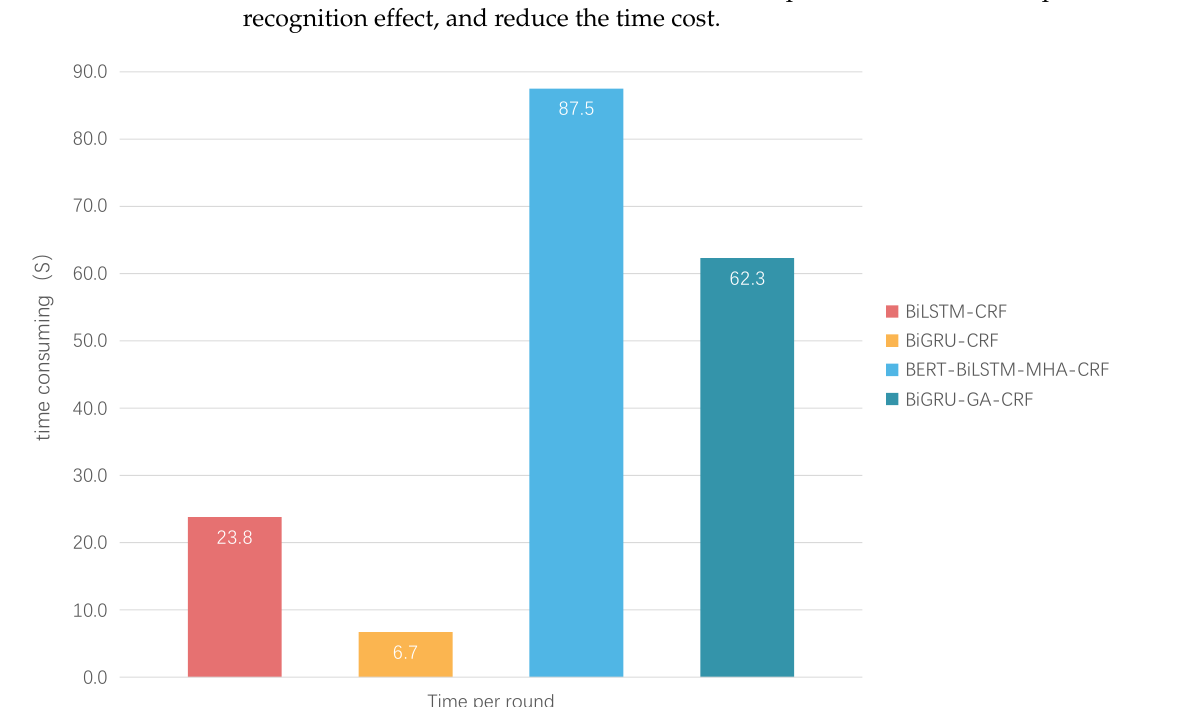
Figure 13. Each round of the entity extraction model takes time to compare the experimental results. In order to verify the effects of the addition of a BERT layer and Gated Attention Mechanism on the experimental results, two groups of ablation experiments were set up in this paper. The model with only the BERT layer was compared with other classical models, and the model with only the Gated Attention Layer was compared with other classical models. The experimental results are shown in the Figures 14 and 15.